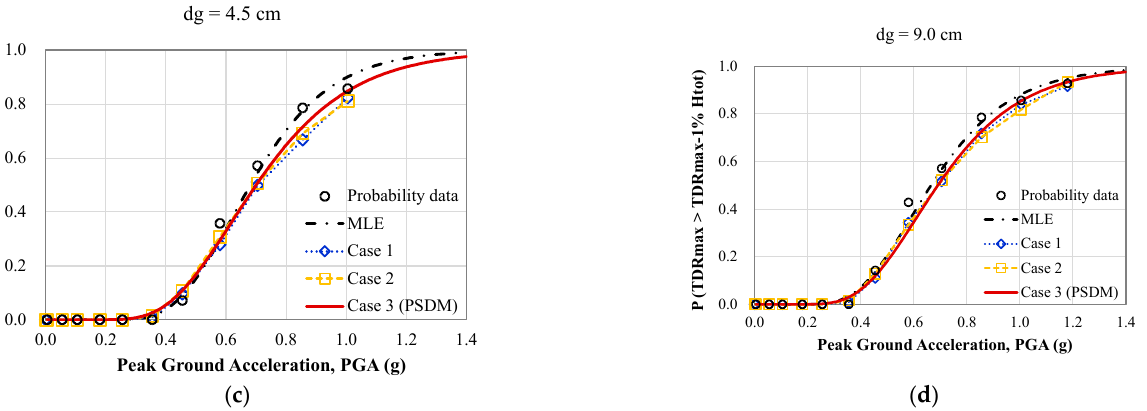
Figure 13. Influence of the PSDM assumptions on the fragility assessment of the eight-story RC frame in terms of TDR max (%H tot ) as a function of the PGA. Examined assumptions: Case 1—lognormality, Case 2—lognormality and power law model, Case 3—PSDM’s assumptions. Fragility curves ( a ) without the pounding effect, ( b ) d g = 0.0 cm, ( c ) d g = 4.5 cm, and ( d ) d g = 9.0 cm.